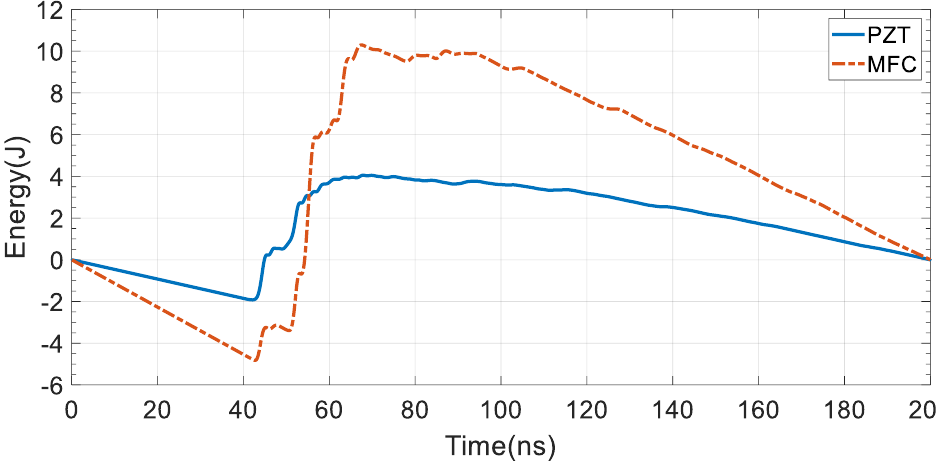
Figure 7. Signal energy curve of acoustic